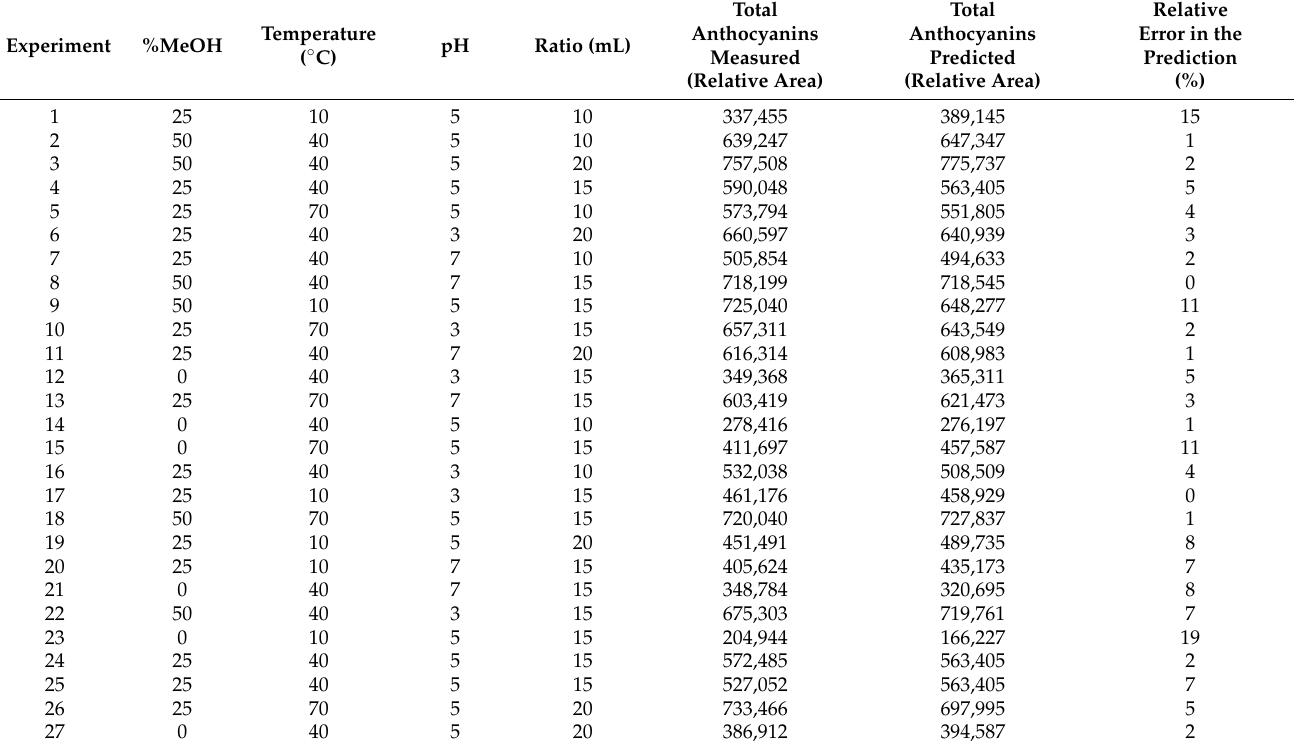
Table 1. Box-Behnken design experiment for the optimization of total anthocyanins extraction from Erica australis flowers.